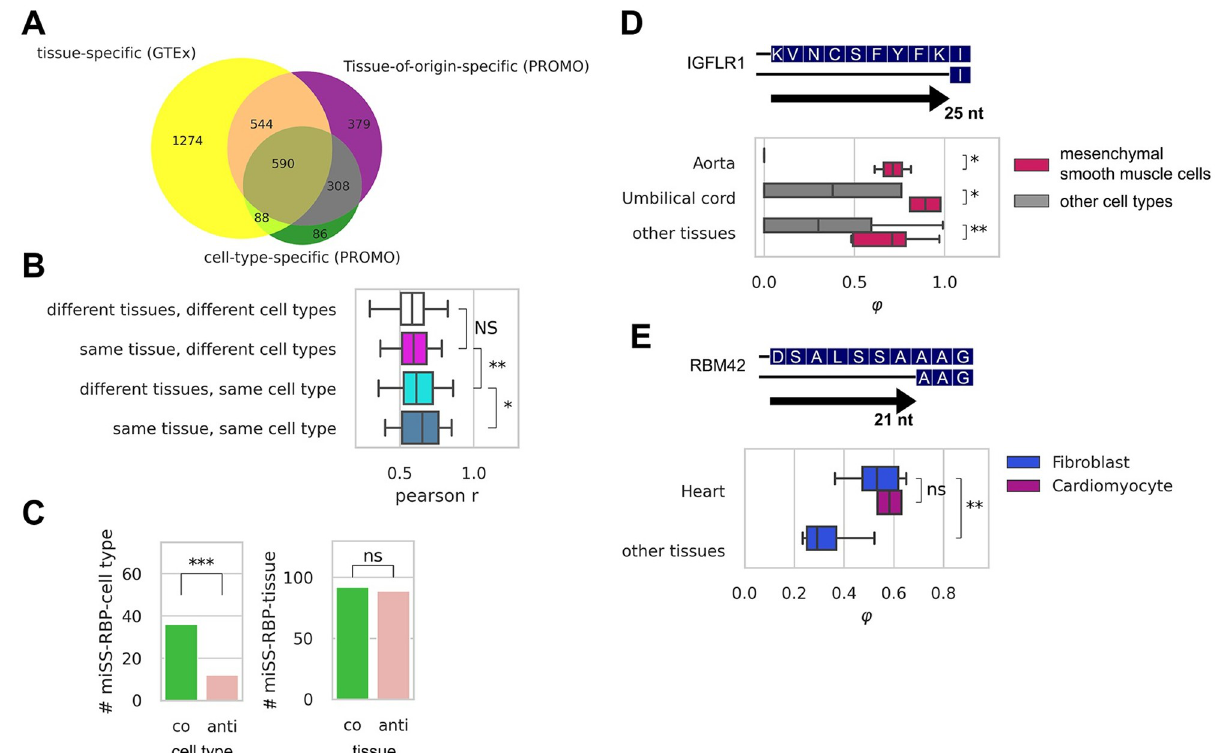
Fig 4. Expression of miSS in cell types. (A) The intersection of tissue-specific miSS identified using GTEx data with cell-type-specific miSS and tissue- of-origin-specific miSS identified using PROMO cells data. (B) The similarity of miSS expression profiles measured by the Pearson correlation coefficient r in the same or different tissues of origin vs. the same or different cell type. (C) . The abundance of co-directed triples significantly exceeds the abundance of anti-directed triples for the association of miSS-RBP-cell type, while there is no significant difference for the association of miSS-RBP- tissue. (D) The expression of an acceptor miSS in exon 2 of the IGFLR1 gene is upregulated in mesenchymal smooth muscle cells regardless of the tissue-of-origin. (E) The expression of an acceptor miSS in exon 6 of the RBM42 gene is upregulated in both heart fibroblasts and heart cardiomyocytes, but not in fibroblasts from other